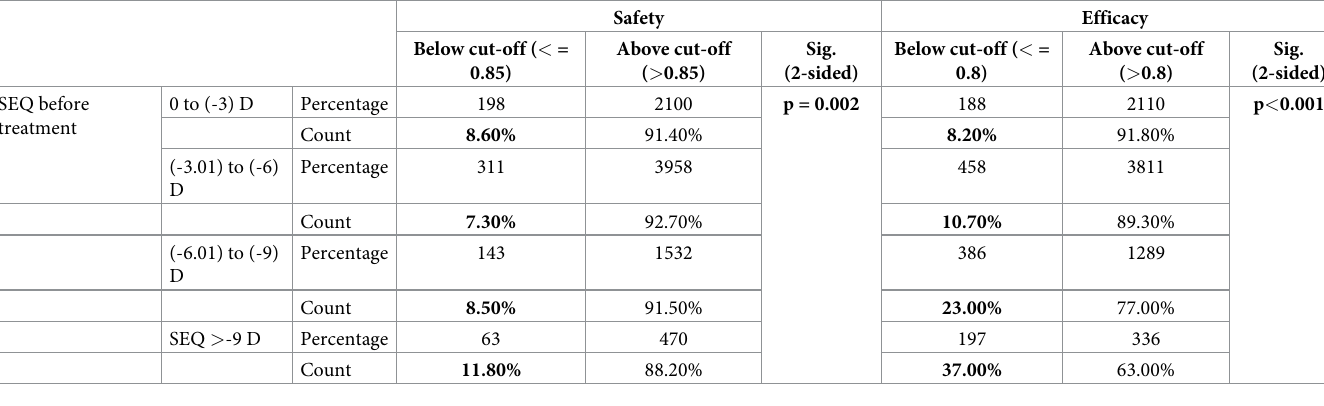
P-value indicates association between SEQ before treatment and outcome above/below cut-off.